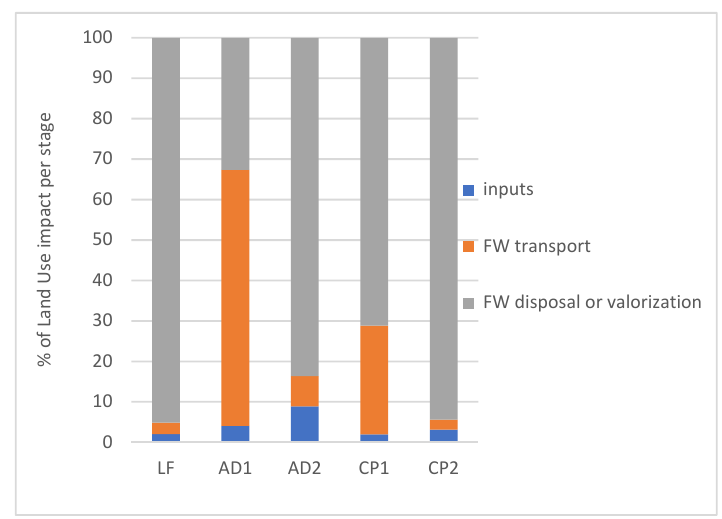
Figure 10. Contribution from each operation stage per FW treatment in the Global Warming Potential category.